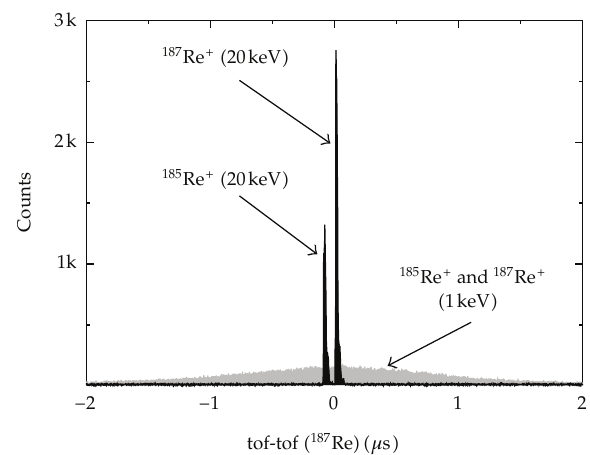
Figure 5: Time-of-flight (cid:3) tof (cid:4) signal of Re (cid:8) ions produced with the laser desorption ion source at two di ff erent kinetic energies: 20keV (cid:3) black (cid:4) and 1keV (cid:3) grey (cid:4) . Both distributions result from the accumulation of 200 cycles. In order to observe them in the same panel, the tof at 20keV is given with respect to the tof of the 187 Re (cid:8) ions (cid:3) 18 μ s (cid:4) , and the one at 1keV with respect to the tof of the Re (cid:8) ions distribution (cid:3) 83 μ s (cid:4)